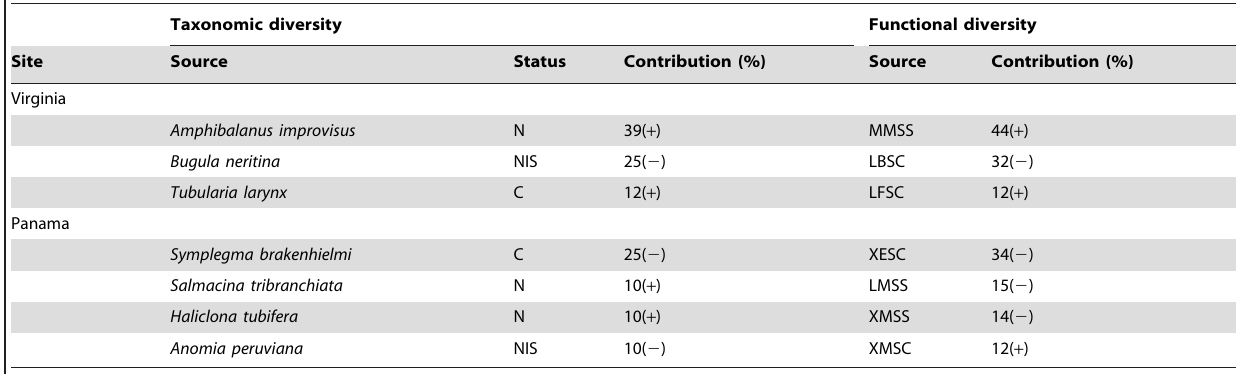
Table 5. Results from the SIMPER routine performed with multivariate data from both Panama and Virginia to identify which species or FG contributed more ( $ 10%) to observed changes in community composition between untreated controls (D0) and highest disturbance